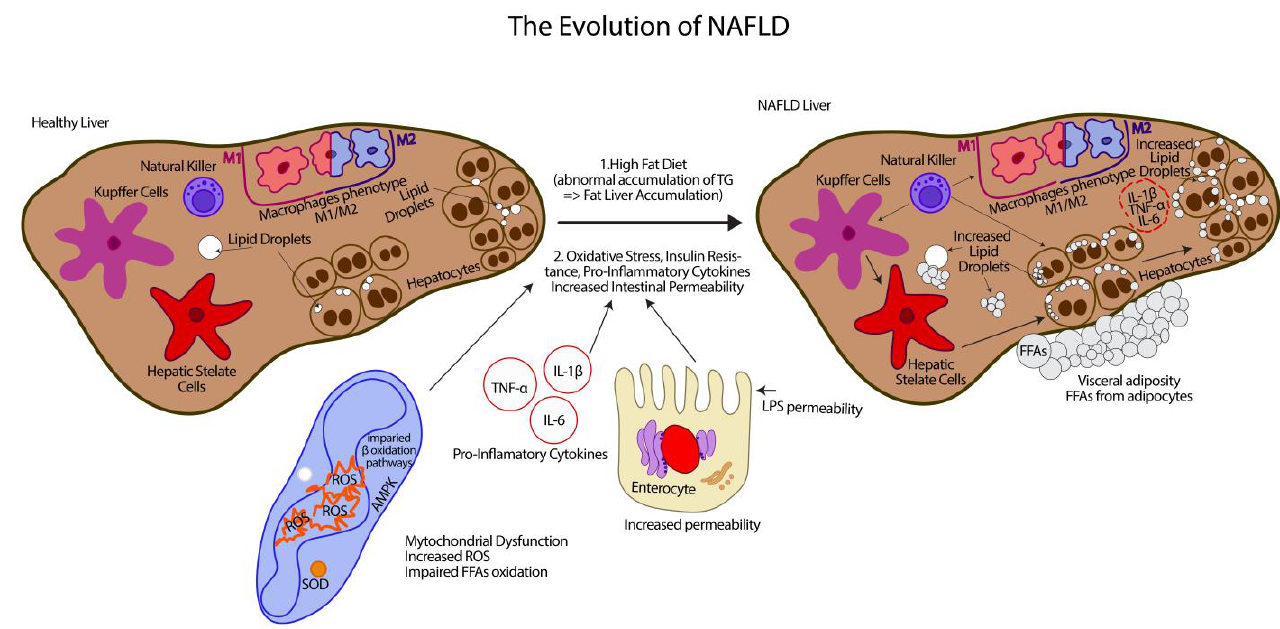
Figure 1. Liver damage in NAFLD.